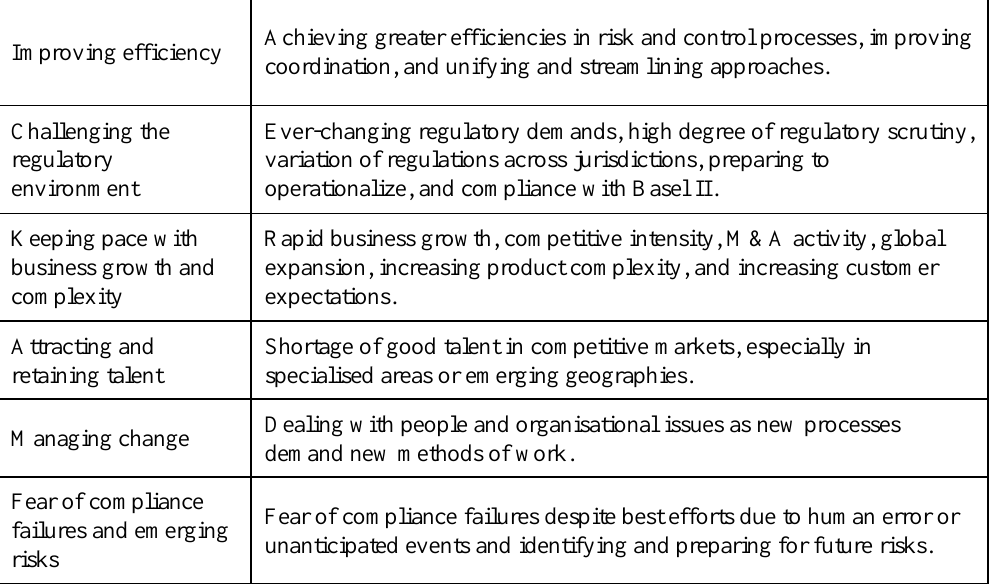
Table 1. Challenges and procedures of banking institutions in the adoption of ERM are described by Vaidyula & Kavala (2011) as shown below: Improving